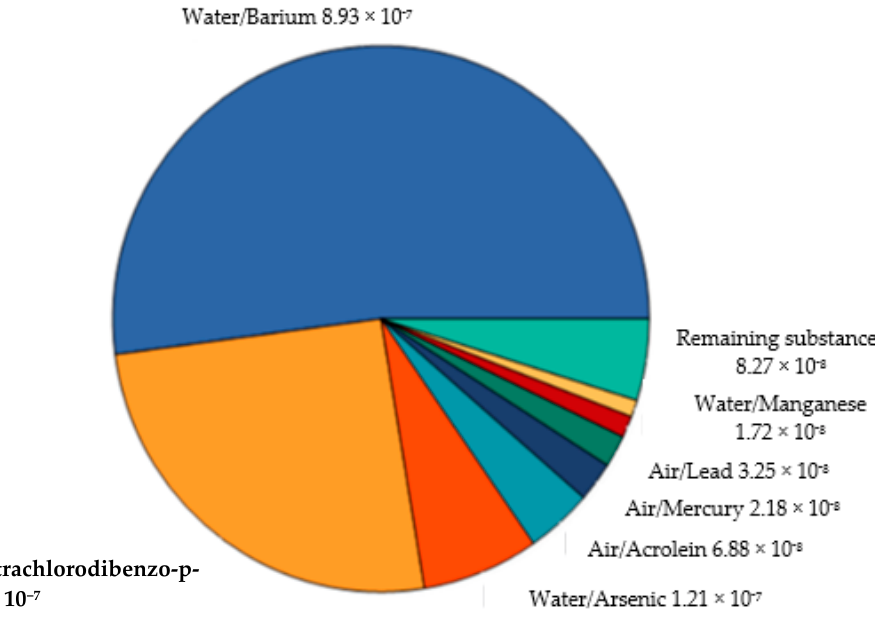
Figure 8. Substances impacting human toxicity analyzed from 1 kg of SPF-reinforced sago starch composite takeout food containers.